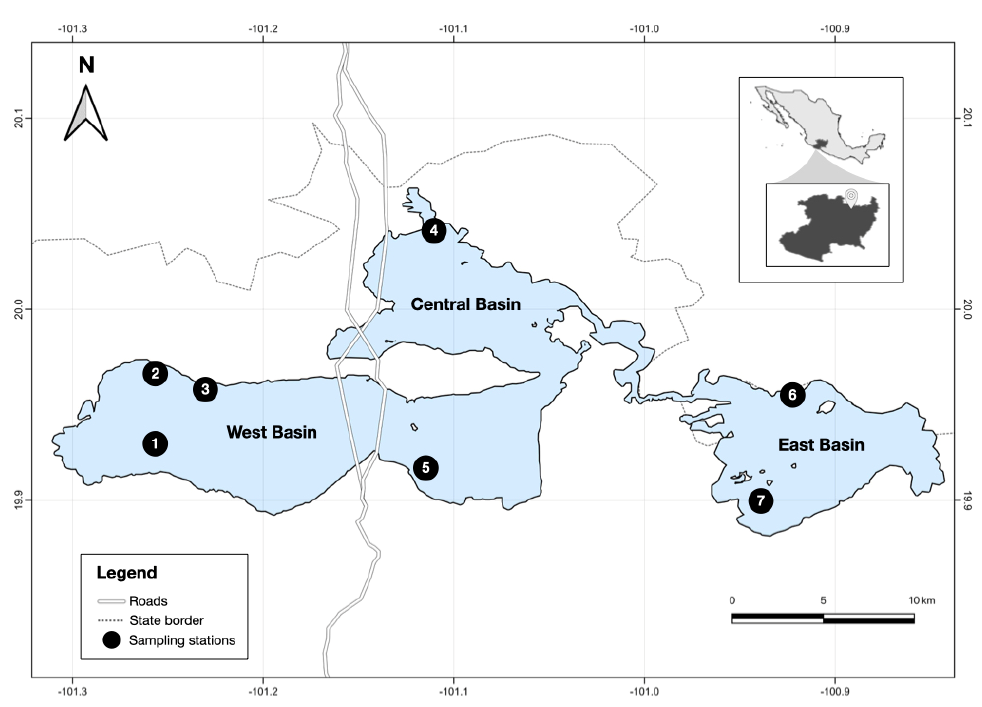
Figure 1. Lake Cuitzeo, Michoacán, in Mexico and Michoacán. (Sampling stations: 1—Congotzio, 2—Bordo, 3—Hacienda, 4—Jéruco, 5—La Palma, 6—Irámuco, 7—Queréndaro).